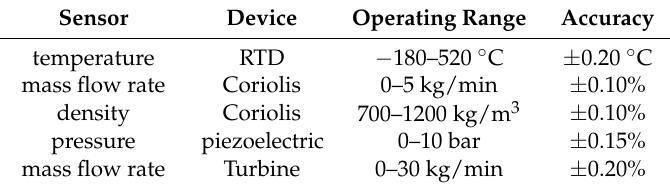
Table 1. Parameters of the sensors used in the experimental study and associated uncertainty